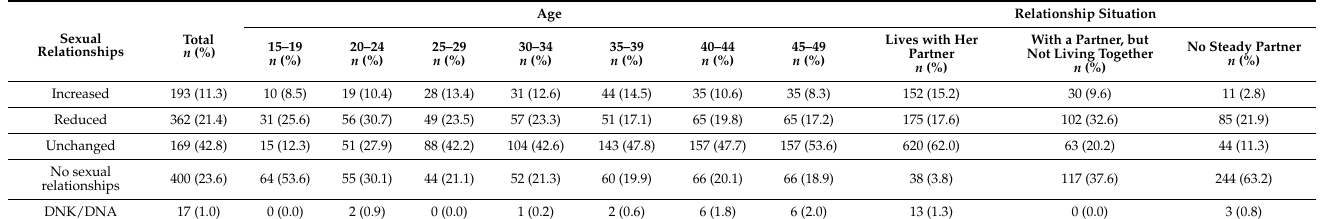
Table 2. Frequency of sexual relationships during confinement in relation to age and relationship situation.